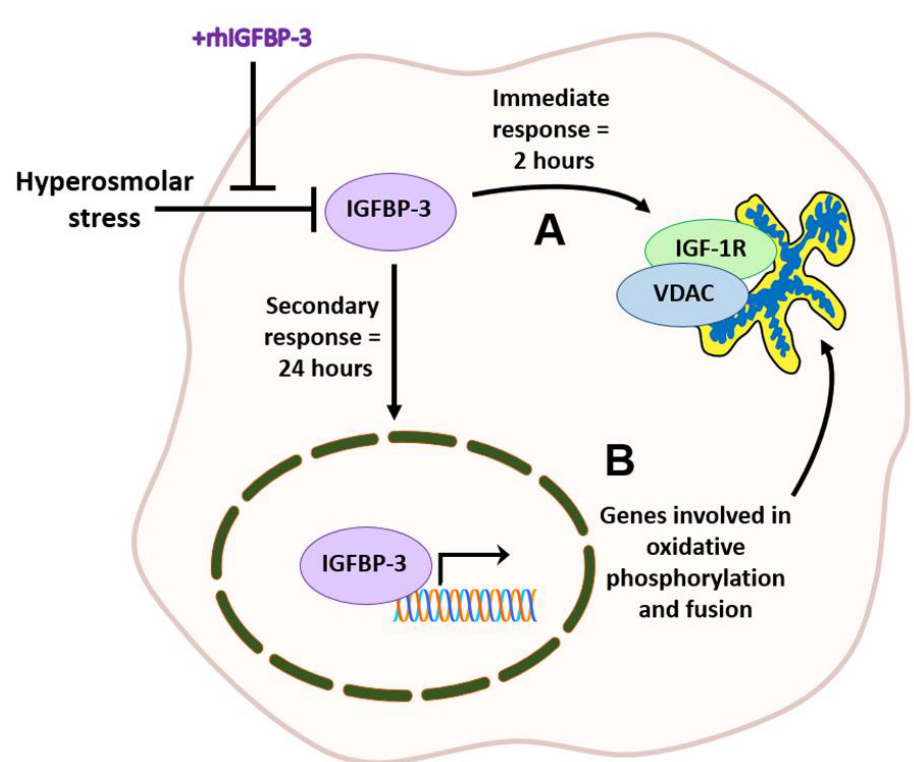
was decreased in the Botox group treated with rhIGFBP-3 compared to saline ( n = 8 mice per group). ( C ) Representative slit-lamp images of corneal fluorescein staining in mice. ( D ) Immunostaining of corneal cryosections for IGFBP-3 (green) and DAPI (blue). Scale bar: 25  m. Graphical data are pre- sented as mean ± standard deviation, one -way ANOVA and SNK multiple comparison test. Slit lamp images representative of 8 mice per group. Immunostaining images representative of 3 mice per group. Gtts: eye drops; PI: post-injection.